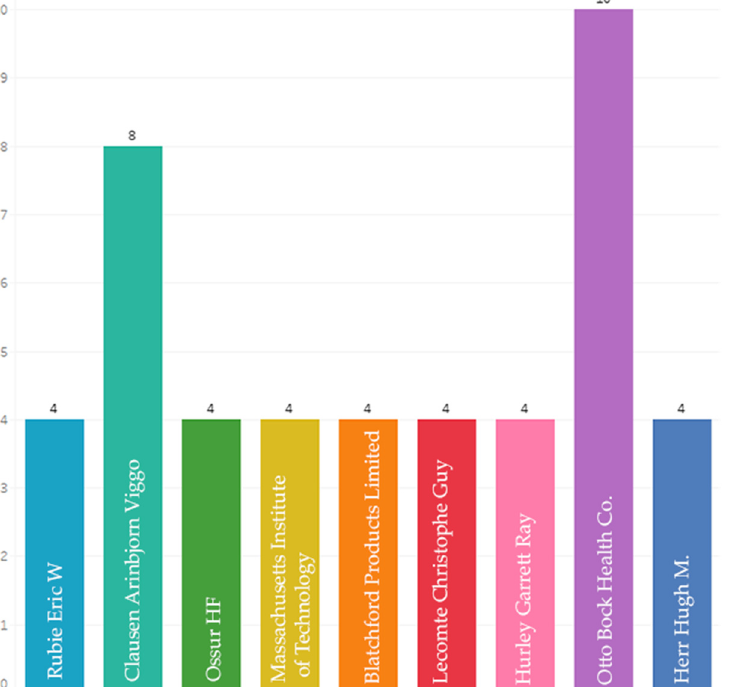
Figure 4. A display of prosthesis types in terms of electronic, hydraulic, and mechanical technology. Applicants and inventors in the databases were considered. Otto Bock Health Co. and Clausen Arinbjorn V. are the main applicants with ten and eight patents, respectively, from 2014 to 2020. Figure 5 shows the main applicants for BKA prostheses.